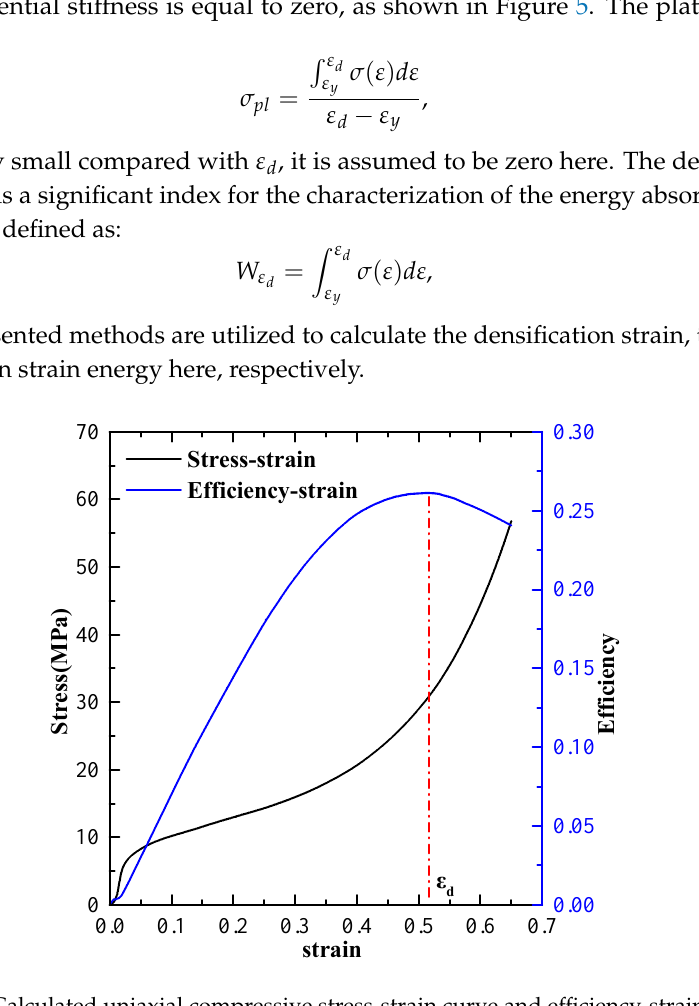
Figure 5. Calculated uniaxial compressive stress-strain curve and efficiency-strain curve. The densification strain, plateau stress and densification strain energy of the SCPA and the SCPA-PU composites, with different relative densities, are shown in Figure 6a–c, respectively. The impact of PU is more pronounced on the densification strain and densification strain energy of the SCPA, as compared with the plateau stress, as shown in Figure 6, which is associated with the low strength and high elasticity of the PU. The densification strain values of the SCPA-PU composites, with the relative density values of 0.263, 0.298, 0.326 and 0.374, are 17.2%, 22.93%, 23.11% and 33.06% higher than those of the SCPA, respectively. At the same time, the plateau stress values of the SCPA-PU composites, with the relative density values of 0.263, 0.298, 0.326 and 0.374, are 9.6%, 8.73%, 6.88% and 7.15% higher than those of the SCPA, respectively. Moreover, the densification strain energy values of the SCPA-PU composites, with the relative density values of 0.263, 0.298, 0.326 and 0.374, are 28.59%, 33.65%, 31.59% and 51.55% higher than those of the SCPA, respectively. The dependence of the densification strain value of the SCPA-PU composites on the relative density is drastically reduced (Figure 6a) when compared with the plateau stress value (Figure 6b) and densification strain energy value (Figure 6c). The densification strain value of the SCPA-PU composites, studied in this paper, can be controlled at about 0.65. Furthermore, it is seen from Figure 6b,c that the relationship between the plateau stress of the SCPA-PU composites and the relative density is similar to that of the densification strain energy and relative density. The two indexes increase with